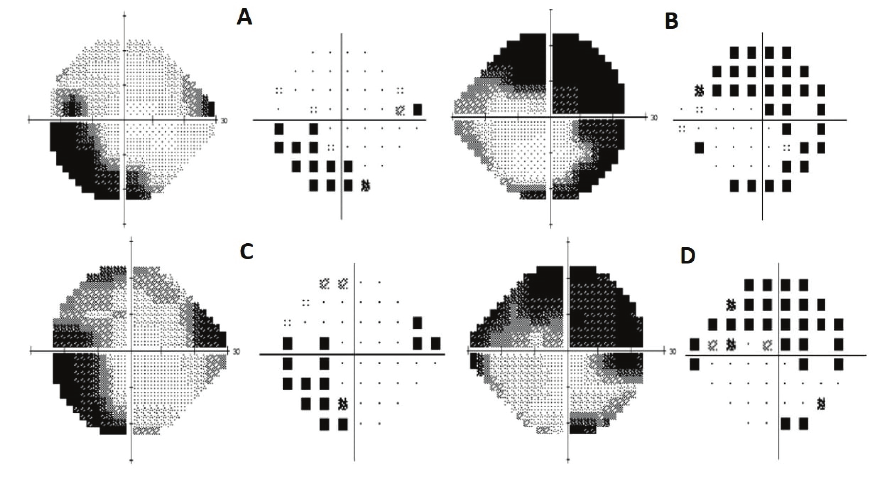
Figure 3. Humphrey visual field 24-II (pattern deviation plot) of the left (A) and right (B) eyes before treatment and the left (C) and right (D) eyes after treatment. They show stability of the visual field during the course of